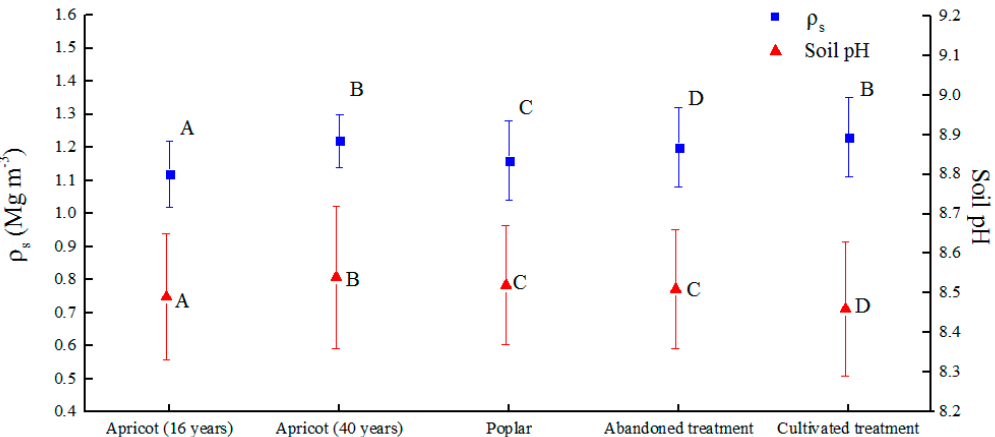
Figure 3. The soil bulk density ( ρ s ) and pH across the 0–1.0 m depth soil profile under different treatments. Different uppercase letters show differences among the 16- and 40-year-old apricot treatments, the poplar treatment, abandoned treatment, and cultivated treatment at p ≤ 0.05. Bars indicate standard deviation of the means.